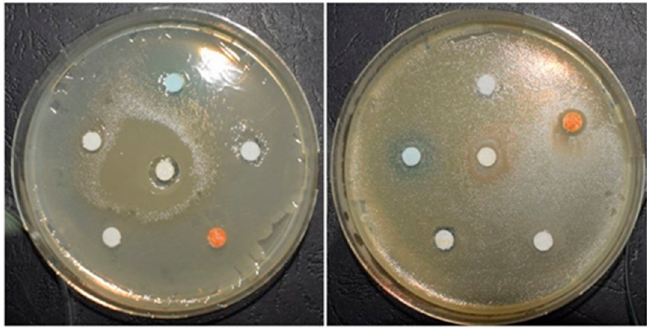
Figure 5. Antimicrobial activity of experimental PS after incubation (left = E. coli ; right = S. aureus ). The diameters of the inhibition zones (mm) for S. aureus and E. coli can be seen in Figure 6.